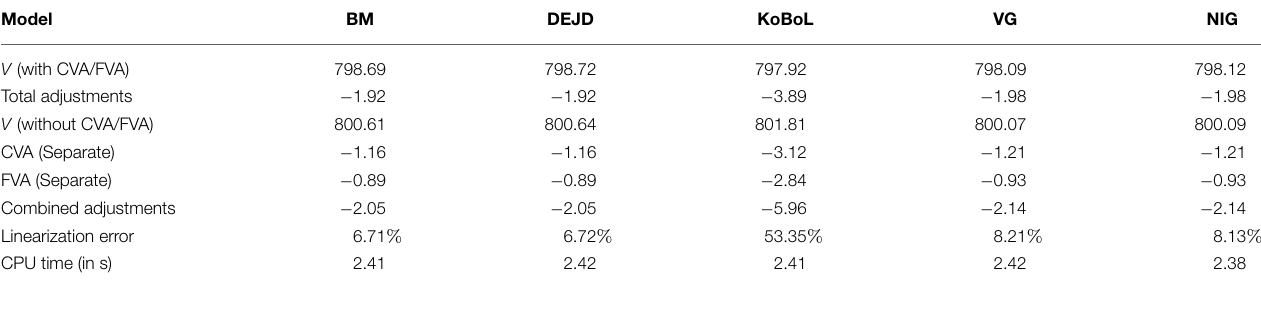
TABLE 2 | Prices of at-the-money European put for different models as of 28 May 2015, time to maturity T = 0 . 0877 , spot S = 27 , 454 . 31 , strike K = 27 , 400 , risk-free rate r = 0 . 25 % , collateral rate r C = 1 % , funding rate r F = 1 . 7 % default intensity λ = 0 . 05 , recovery rate R B = 0 . 4 , collateral threshold H B = 500 . Model BM